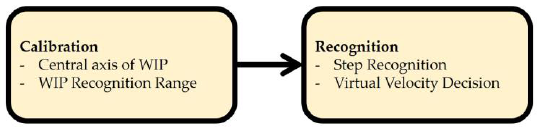
Figure 2. Overview of the two phases of the proposed method. WIP: Walking-in-place.